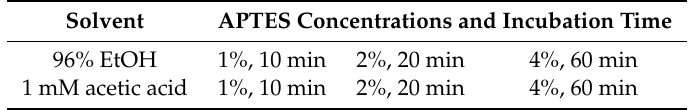
Table 1. Overview of silanization parameters used in this